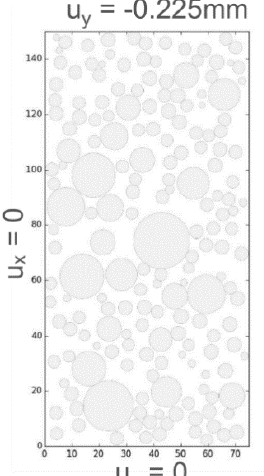
Figure 5. Synthetic specimen with loading and boundary conditions implemented in Abaqus